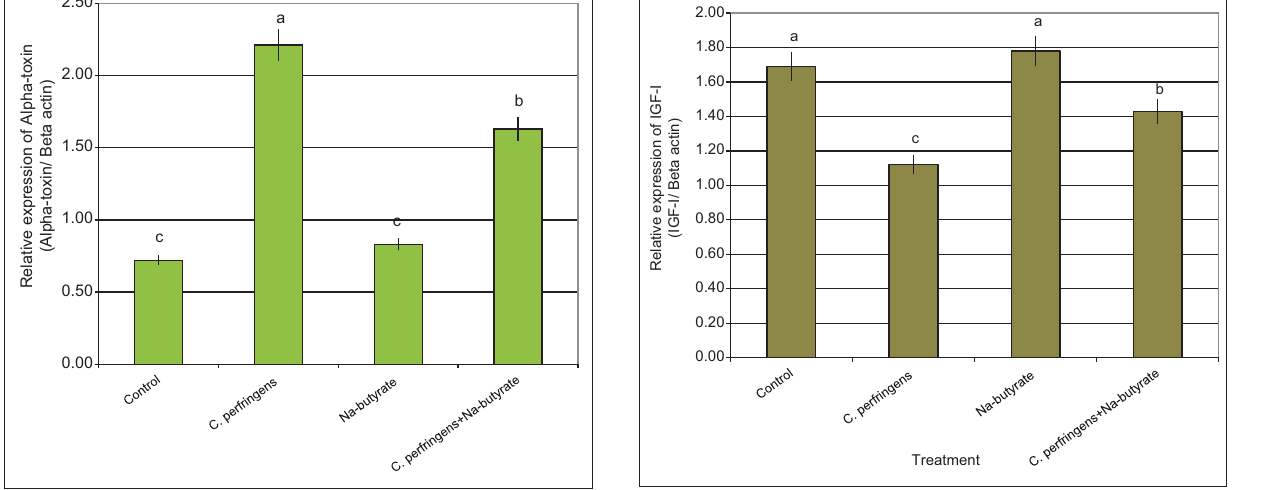
Figure-2: Semi-quantitative real time-polymerase chain reaction analysis of alpha-toxin-mRNAs in bursa tissues collected from chickens infected with C. perfringens and/or Na-butyrate. a,b,c Means with different letters, differ significantly (p ≤ 0.05).